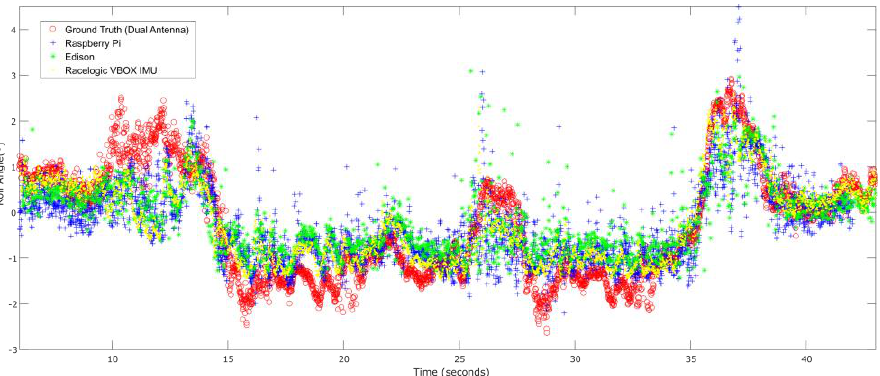
Figure 6. ANN estimated + ground truth roll angle for J-Turn maneuver.